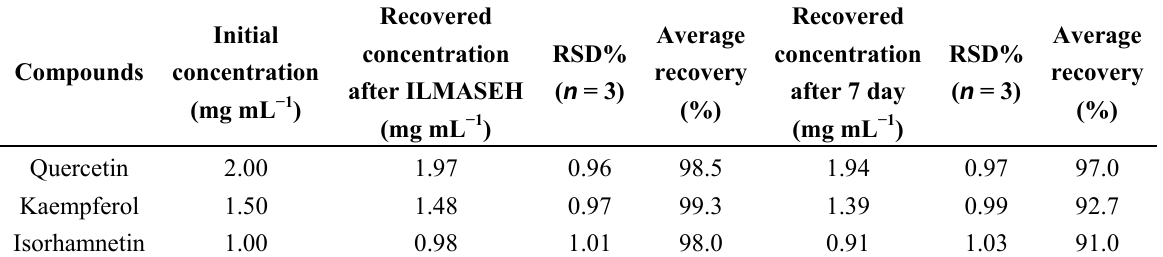
Table 2. Stability studies of quercetin, kaempferol, and isorhamnetin standards